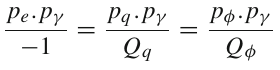
Fig. 2 Variation of cos θ ∗ with respect to